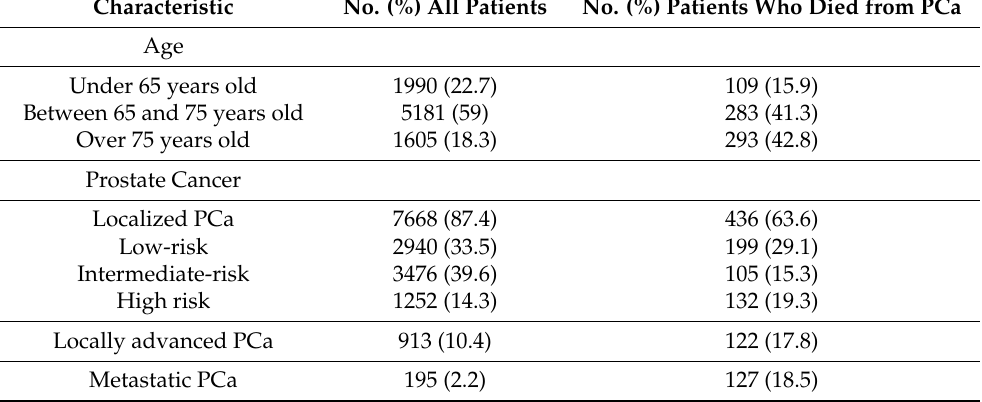
Table 1. Characteristics of patients with prostate cancer and patients who died from prostate cancer within 10 years after diagnosis in the PLCO